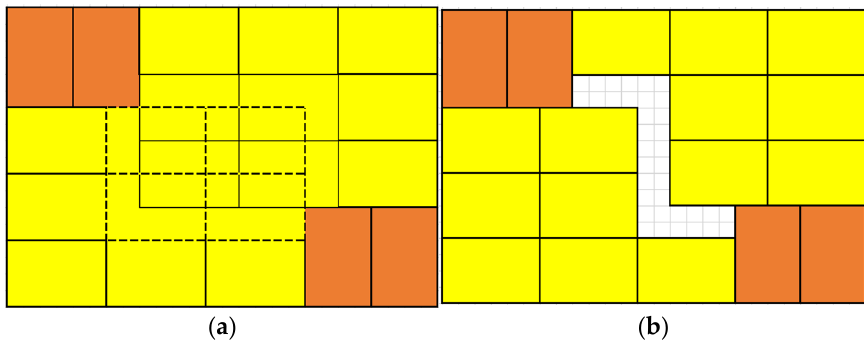
Figure 8. Horizontal multi-object overlap. ( a ) Before removal. ( b ) After removal.